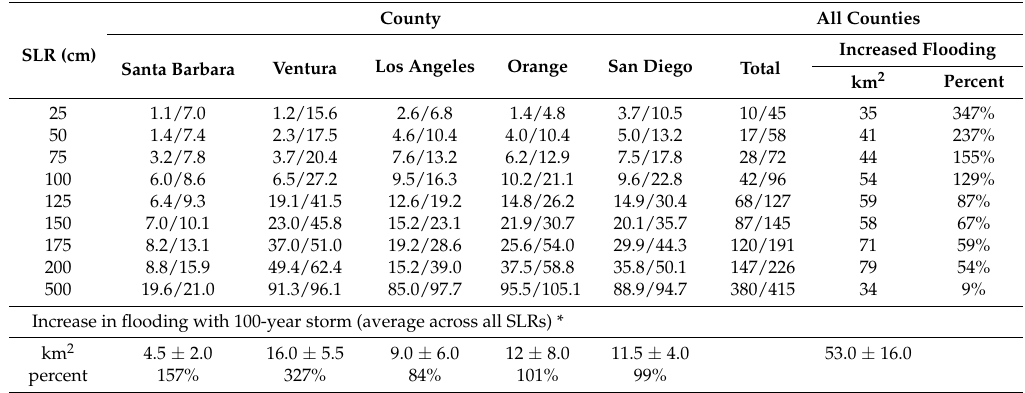
Table 1. Area (km 2 ) flooded due to sea-level rise (SLR) alone and SLR in combination with the 100-year coastal storm (SLR only/SLR plus 100-year coastal storm). Bottom row shows increase in flood area from impact of 100-year coastal storm (average across all SLR values) for each county and across all